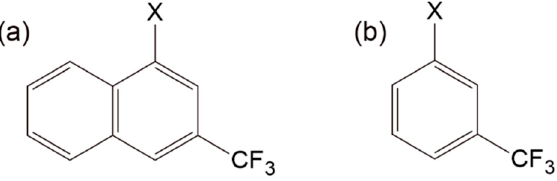
Figure 6. Similarity of 3 ‐ trifluoromethyl ‐ 1 ‐ X ‐ naphthalene 1 ‐ 3 ( a ) and m ‐ trifluoromethyl ‐ X ‐ benzene X ‐ ( m ‐ Ph) ‐ CF 3 ( b ).